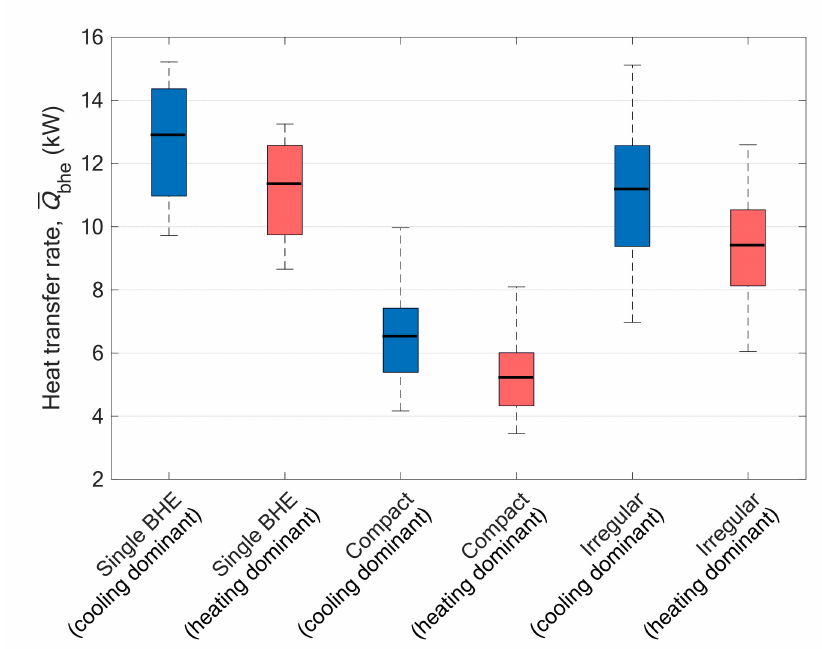
Figure 9. Range of heat transfer rates per borehole ( Q bhe , kW) according to test BHE